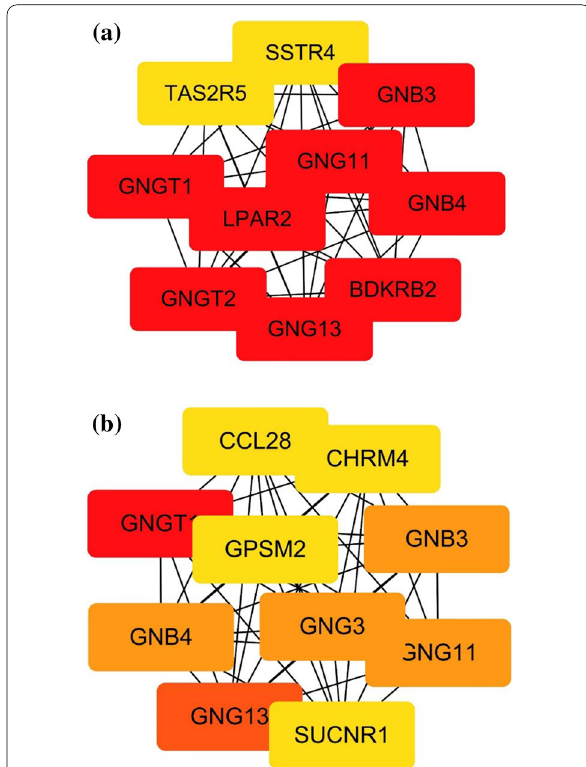
Fig. 5 a Using the CytoHubba plugin of Cytoscape to screen the top 10 genes on the PPI network of the daily alcohol user group. The darker the color, the more important the gene is. b The top 10 genes were also screened for the PPI network of the non-daily alcohol user group. From the two figures, it can be found that there are differences between the two groups of hub genes